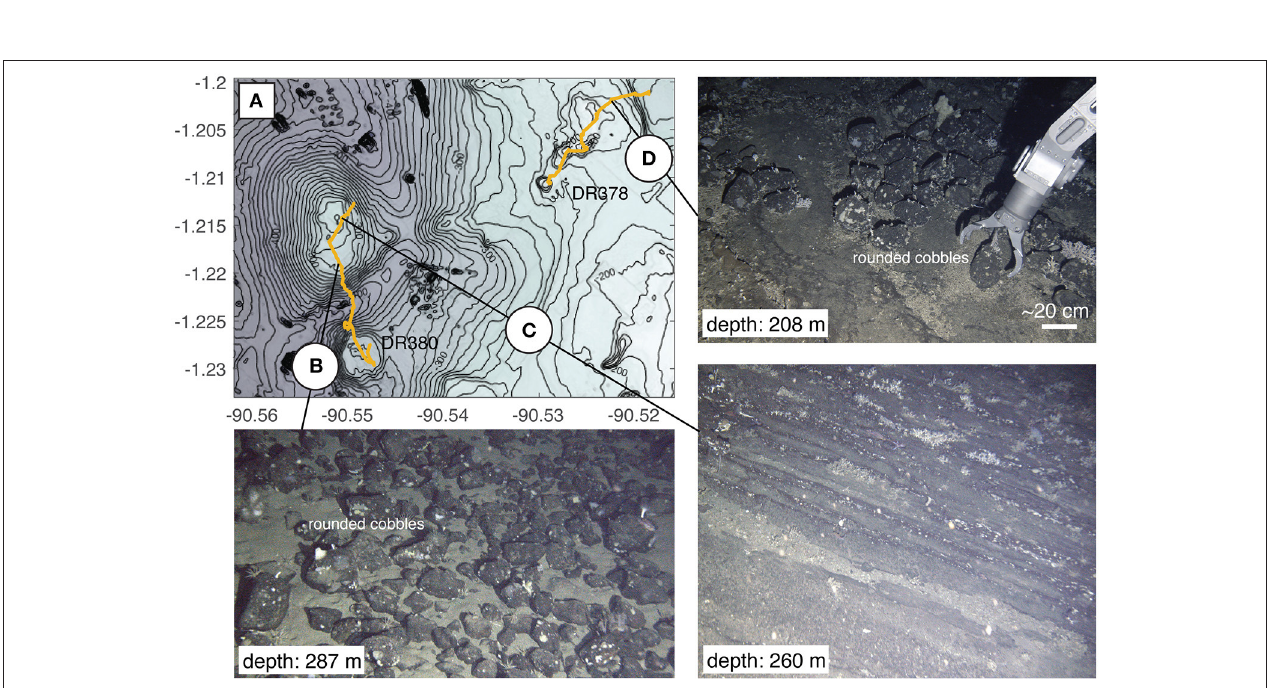
FIGURE 8 | Map of DR378 and DR380 seamounts. (A) Bathymetric contour interval is 10m. Gold lines shows dive tracks for seamounts DR378 and DR380. The two seamounts visited on seamount DR380 have terraced/flat summits. The northernmost of the two is irregular in plan view, with small embayments on the western flank and has a small summit spire. The southernmost is round with no irregular summit features, except for its flat top, and resembles seamounts found in the Fernandina region ( Figure 9 ) (B) Field of rounded cobble-boulder sized clasts setting on a flat surface obscured by fine sediment. (C) Near vertical outcrop of sub-horizontally bedded volcaniclastic material. (D) Collection of rounded cobble from top of terrace. Depths in photos indicate the depth of the seafloor at the point of image capture.